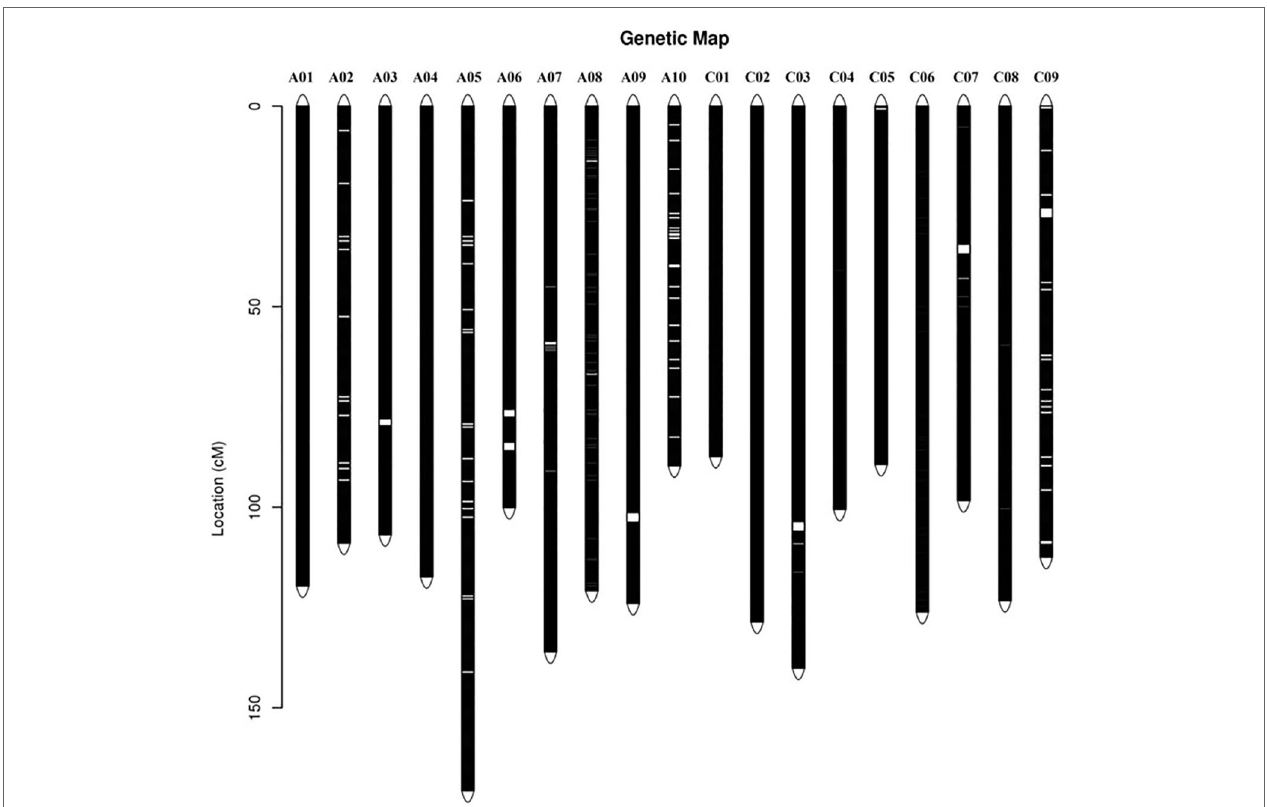
FIGURe 2 | Distribution of single nucleotide polymorphism (SNP) markers on the ultra-dense genetic map. Bars on the linkage groups indicate SNP markers, while the y -axis determines the genetic distance in centimorgans (cM).